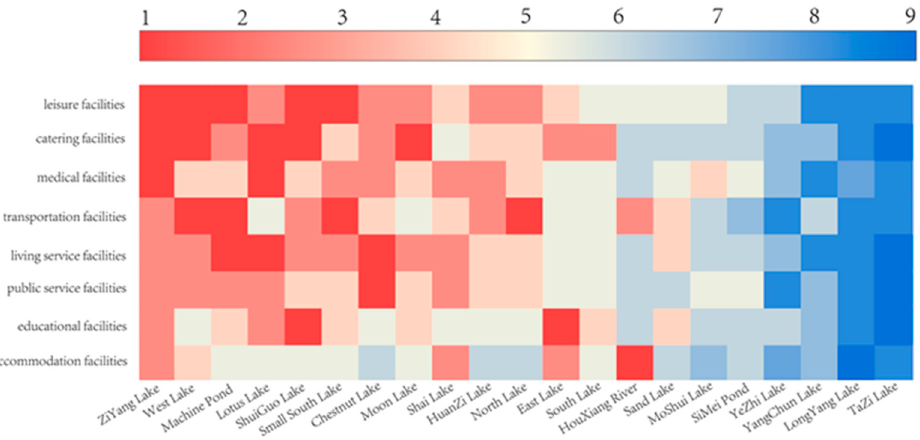
Figure 10. POI cluster level thermal map.